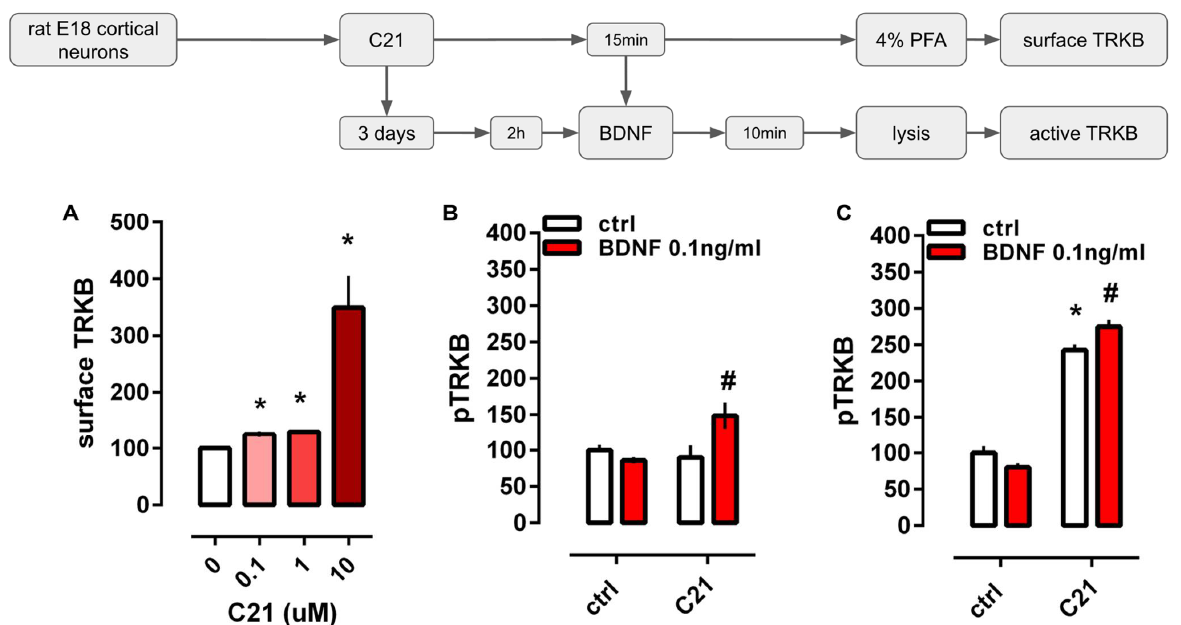
Figure 1. In vitro effects of C21 on TRKB surface exposure and activation. ( A ) Acute administration of C21 (shades of red bars, 0.1–10 µ M/15 min) increased the surface exposure of TRKB in cultured cortical cells from rat embryos ( n = 19–24/group). ( B ) Administration of C21 (10 µ M/15 min) facilitated the effect of an ineffective dose of BDNF (0.1 ng/mL/10 min, red bars). ( C ) The longer administration of C21 (10 µ M/3 days) increased pTRKB levels per se but still facilitated the effect of BDNF (0.1 ng/mL/10 min, red bars). Data expressed as mean ± SEM from ctrl/ctrl or 0 groups. * p < 0.05 from ctrl/ctrl or 0 group; # p < 0.05 from C21/ctrl ( n = 8–12/group: Fisher’s LSD).